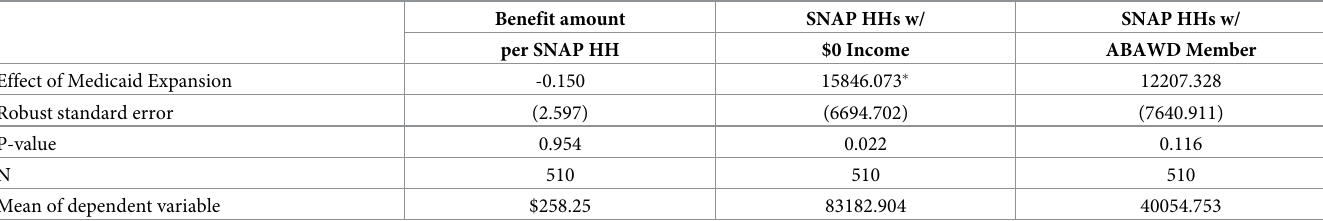
Table 3. ACA Medicaid expansion effects on SNAP benefit amount and characteristics of participating households.